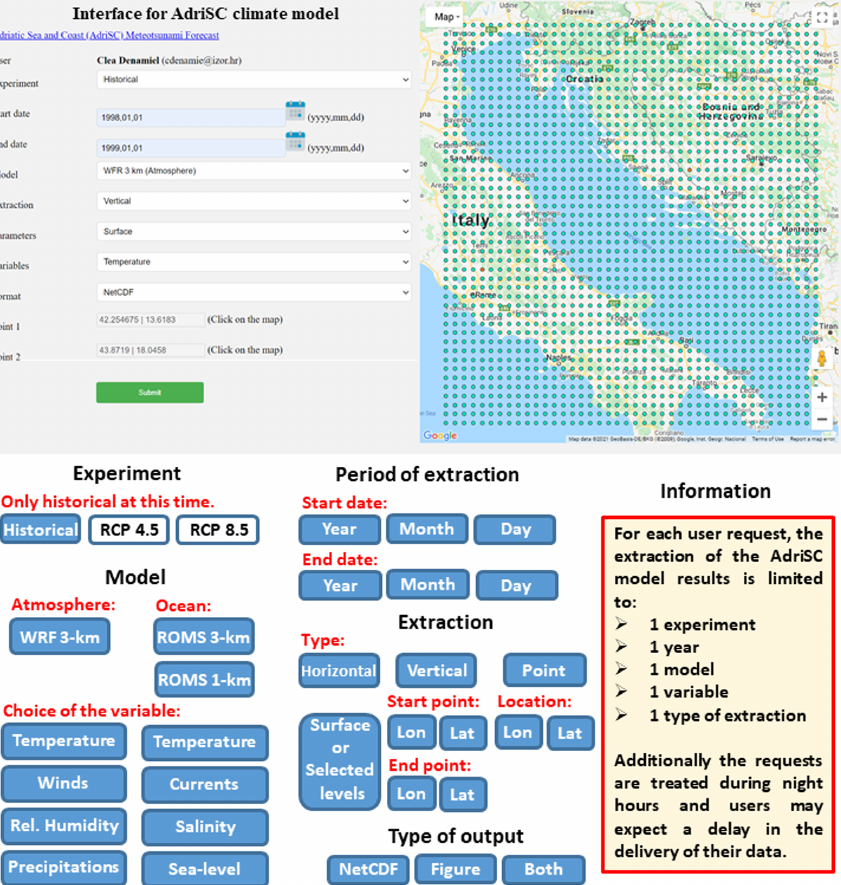
Figure 2. Interface for the extraction of the AdriSC climate model results available at https://vrtlac.izor.hr/ords/adrisc/interface_form (last access: 23 June 2021) (top panel) and schematic representation of the available options of extraction (bottom